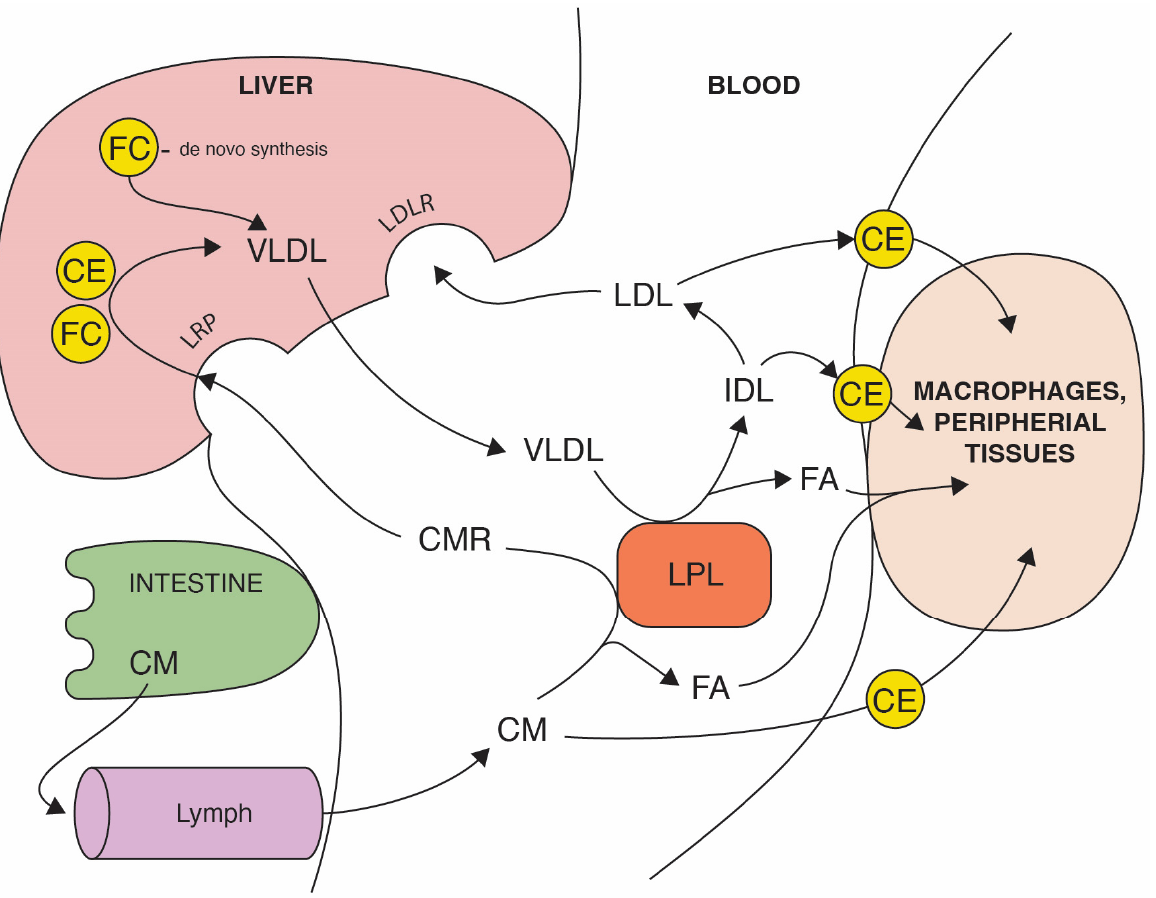
Figure 1. The route of dietary and endogenous cholesterol in an organism. The absorption of dietary triglycerides, free cholesterol (FC), and cholesterol esters (CE) occurs in the small intestine. In enterocytes, dietary lipids are packed in chylomicrons (CM) that are diffused to the bloodstream via lymph. After the digestion of triglycerides by lipoprotein lipase (LPL), fatty acids (FA) are absorbed by target cells and chylomicrons remnant (CMR) uptake to the liver is mediated by LDL receptor-related protein (LRP). The endogenous cholesterol pathway starts from the liver, recirculating triglycerides and cholesterol in the bloodstream, packed in very low-density lipoproteins (VLDL). VLDL through the LPL activity delivers FA to peripheral cells and are metabolized to intermediate-density lipoproteins (IDL) which are enriched in cholesterol. Low-density lipoproteins (LDL) derived from IDL carry the majority of the cholesterol and transports mostly esterified cholesterol (CE) to peripheral tissues, including macrophages in vein walls. LDL are eventually cleared by the liver via the LDL receptor.